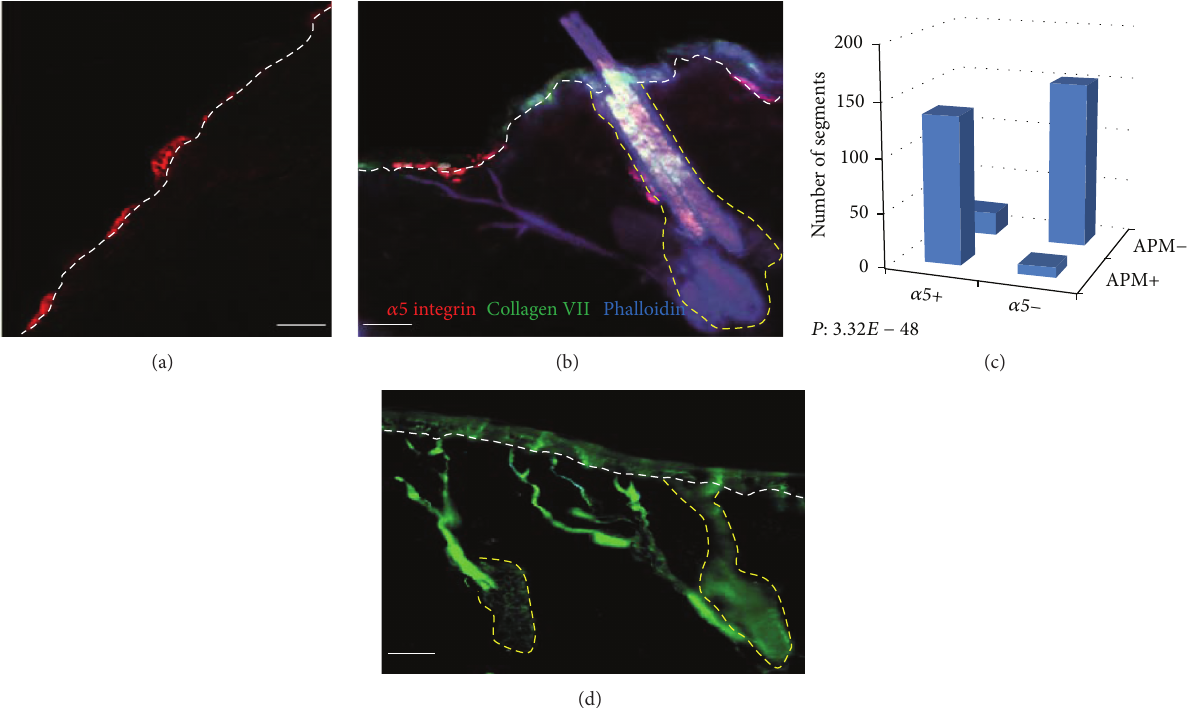
Figure 1: 𝛼 5 integrin and phalloidin staining delineate the distal tips of the arrector pili muscle. Immunofluorescence microscopy showing patterns of phalloidin, expression of 𝛼 5 integrin, and collagen VII. (a-b) 𝛼 5 integrin (red) demonstrates a heterogeneous expression in the basal epidermis. (b) Triple immunofluorescence staining for 𝛼 5 integrin (red), collagen VII (green), and phalloidin (blue) showing marked overlap of 𝛼 5 integrin and phalloidin in the basal epidermis at the distal tip of the arrector pili muscle. (c) Strong correlation between 𝛼 5 integrin expressing cells and cells stained with phalloidin. (d) Extensive branching of the APM (phalloidin-stained) as it ascends and attaches to the dermoepidermal junction. Scale bar: 100 𝜇 m.